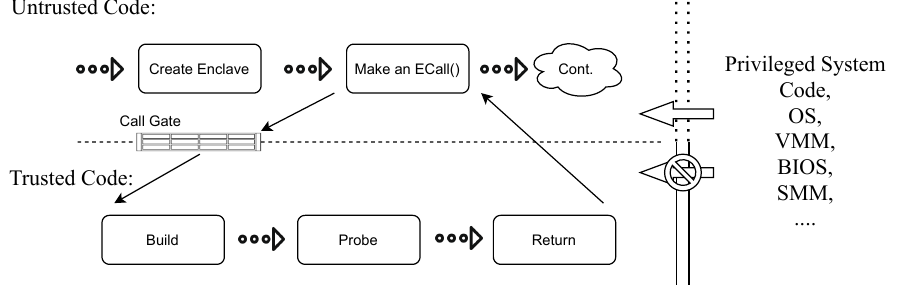
Figure 1. Application execution flow on Intel